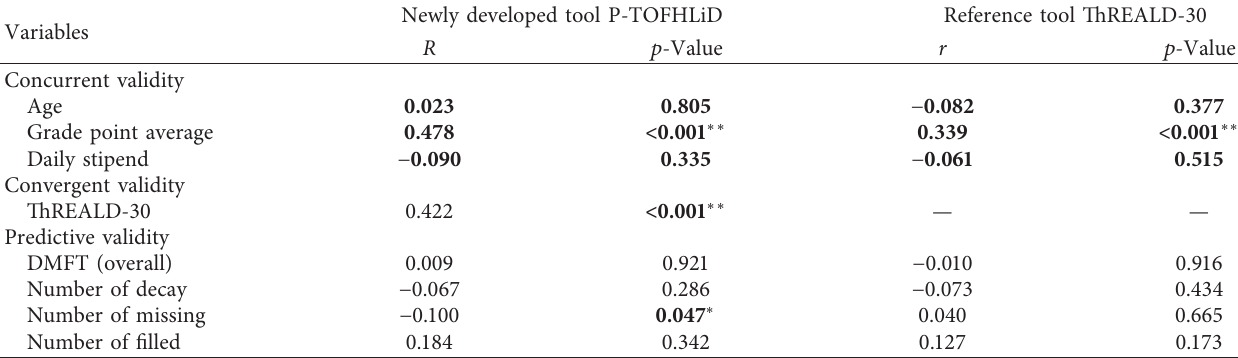
Table 1: Correlations of the P-TOFHLiD with variables for different validity